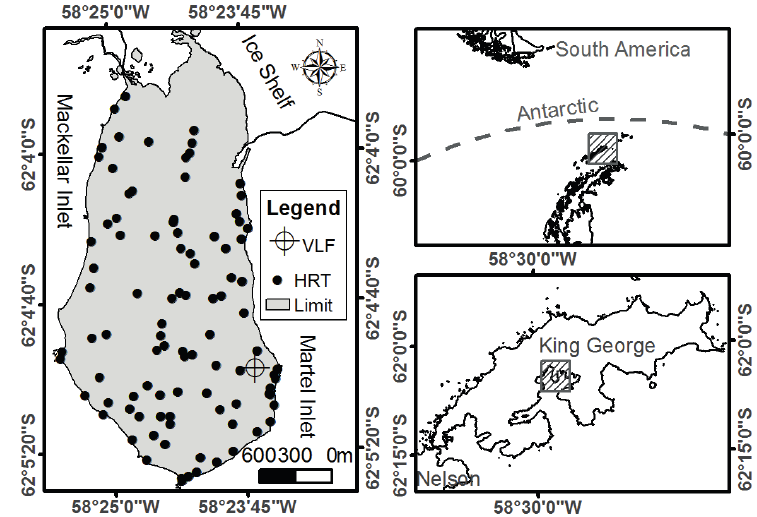
Figure 1 - Illustrative location map of the study area, indicating the stations points (HRT) and the GNSS base (VLF) for post-processing